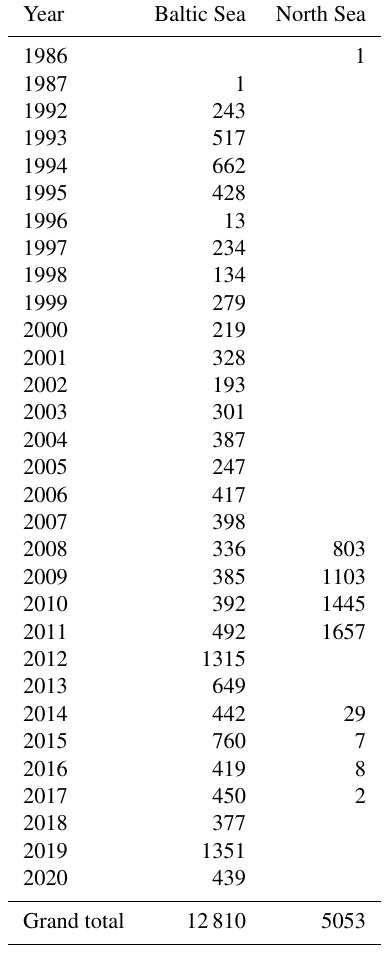
Table 1. Years of material collection and number of corresponding measurements per region included in the